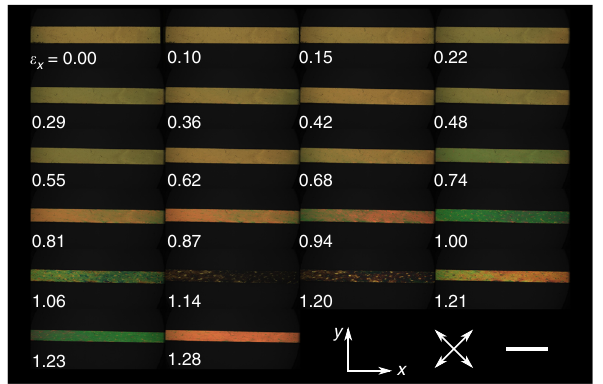
Fig. 5 Negative LCOP order from polarising microscopy. Polarising microscopy textures at each strain step of test I . The birefringence colours indicate the retardance initially decreases, becoming zero at ε x = 1.14, before increasing again. Scale bar, 5